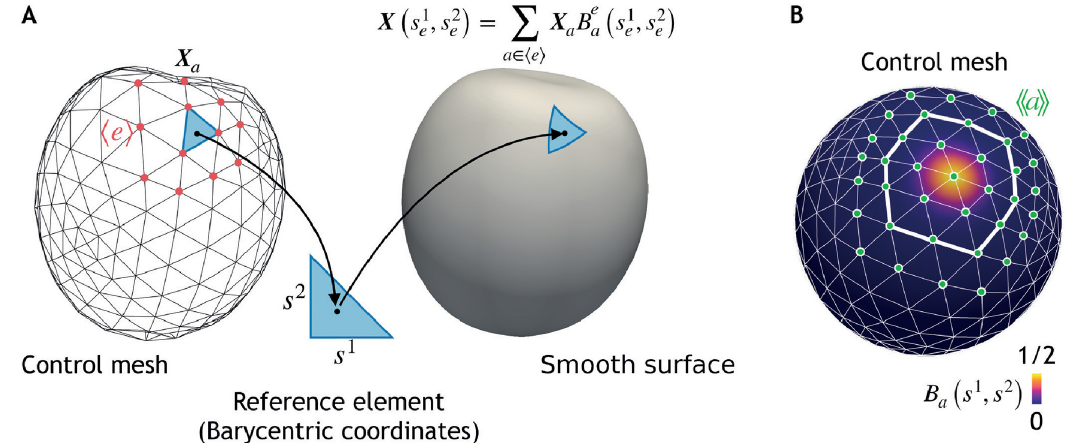
Fig 2. A smooth surface S representing a cell is obtained based on a triangular control mesh with vertex positions X (A) and a a set of basis functions per vertex a (B). (A) To define the mapping between the control mesh and the cell surface, the barycentric coordinates of points in a triangular element e in the control mesh s 1 ; s 2 , which span a reference triangle, are used to define a point e e on the cell surface S , X ð s 1 ; s 2 Þ (Eq (9)). Points X ð s 1 ; s 2 Þ are obtained by summing basis functions B ð s 1 ; s 2 Þ , weighted by X , over a a e e e e e e vertices a whose basis functions have a non-zero contribution to this element, an ensemble denoted h e i . (B) Example of the basis function associated to a vertex in the mesh. For Loop subdivision surfaces basis functions, the basis function spans the first and second rows of elements surrounding the vertex (thicker white line). The vertices that interact with vertex a in the same cell, represented by the set hh a ii (green) are formed by the first, second, and third nearest neighbours in the mesh.